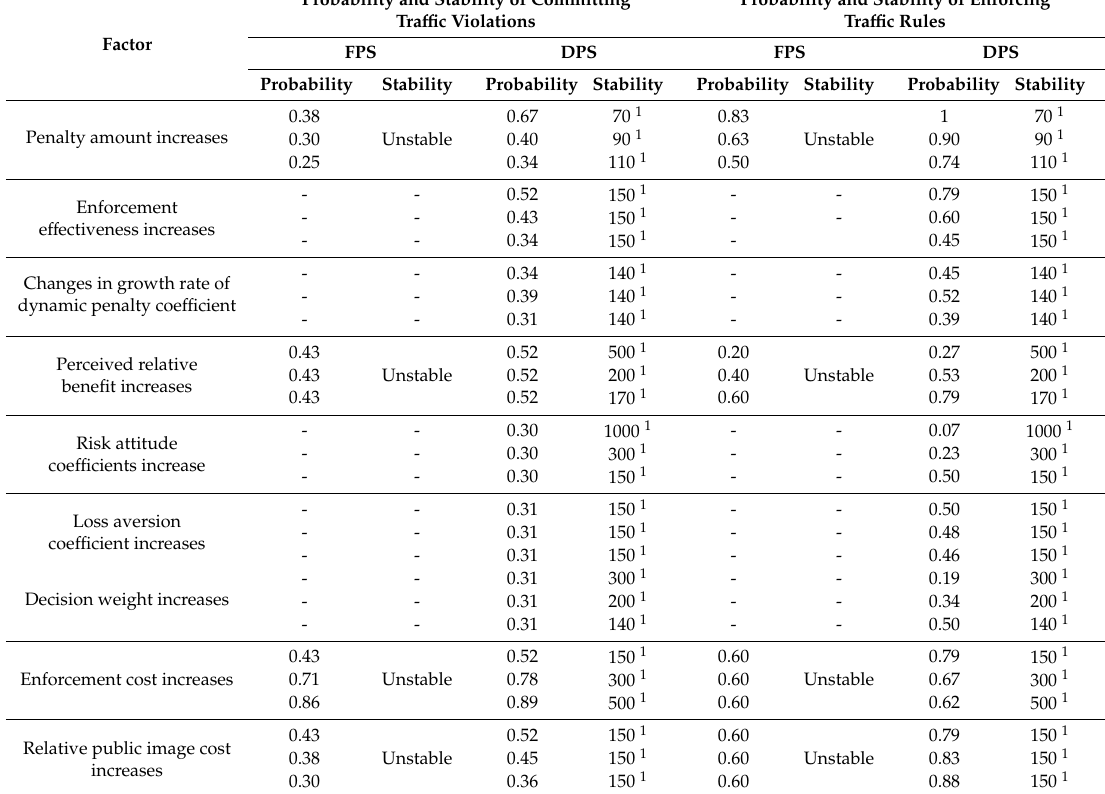
Table 9. Probabilities at the equilibrium and stabilities under FPS or DPS in Situation